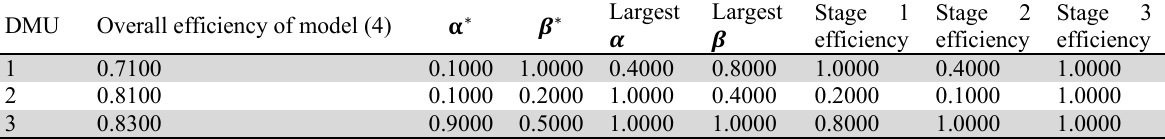
Numerical results for data in Table 5 with values of (cid:2012)(cid:2009) (cid:3404) (cid:2012)(cid:2010) (cid:3404) 0.1 DMU Overall efficiency of model (4)